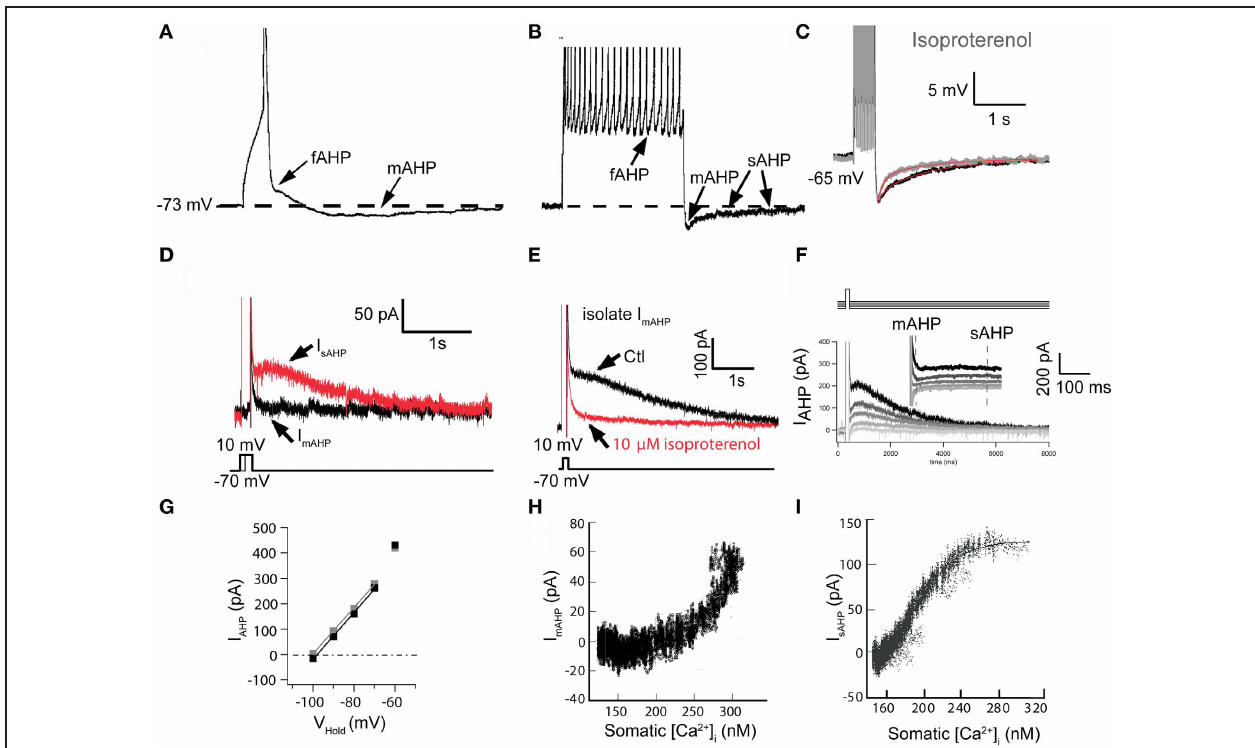
Figure 7B in Abel et al. (2004)]. (E) In a different cell, the I sAHP tail current following a 200ms voltage step to 0mV and then returning to − 70mV was blocked by 10 μ M isoproterenol, isolating I mAHP [modified from Figure 7C in Abel et al. (2004)]. (F) Reversal potential for I sAHP . Tail currents were elicited by a 200ms step to + 10mV and amplitudes were measured upon return to various potentials. I mAHP was measured as the peak response and I sAHP was measured at 500ms after the peak, when I mAHP had completely decayed [modified from Figure 8A in Abel et al. (2004)]. (G) Plots of I AHP amplitudes from data in (F) . Extrapolated reversal potentials approximated E K , as determined by the Nernst equation [ E K = − 102mV: modified from Figure 8B in Abel et al. (2004)]. (H) Plot of isolated I mAHP vs. bulk cytoplasmic [Ca 2 + ] i . Since the underlying SK channels respond to a sub-membrane microdomain of [Ca 2 + ], the dose-response relationship is distorted [data from eight cells; modified from Figure 10C in Abel et al. (2004)]. (I) Plot of isolated I sAHP vs. bulk cytoplasmic [Ca 2 + ] i . Note the sigmoidal dose-response curve indicating response to a “well-mixed” bulk [Ca 2 + ] i [data from five cells; estimated K D = ∼ 200nM, Hill coefficient ∼ 4.5: modified from Figure 9C in Abel et al. (2004)]. Panels A and B were from layer 5A of somatosensory cortex. Panels C – I were from layer